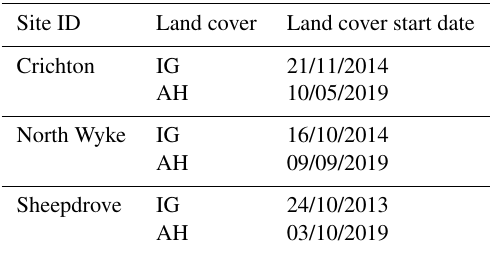
Table 2. Changes in land cover at COSMOS-UK